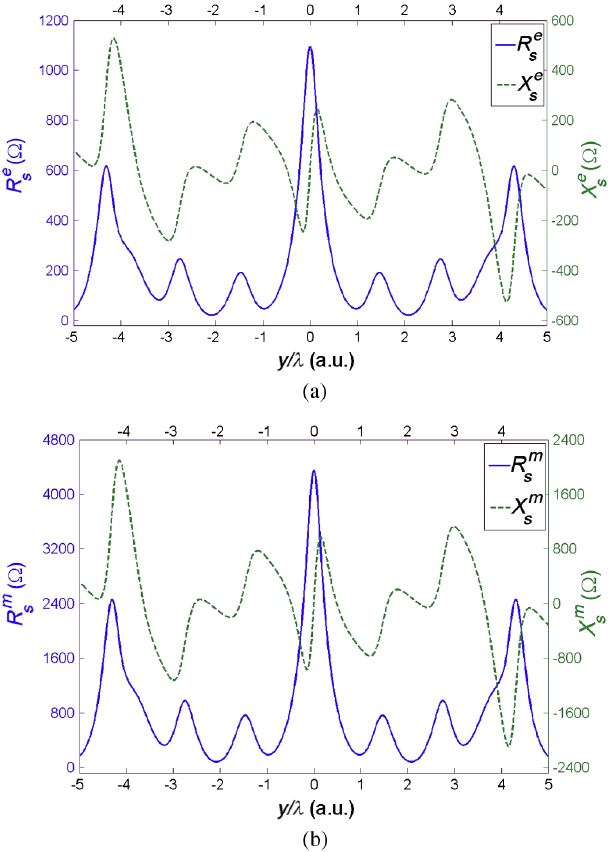
FIG. 2. The required (a) electric and (b) magnetic surface impedances that satisfy the boundary conditions for the field distribution shown in Fig. 1. R and X respectively represent the s s real and imaginary parts of the complex